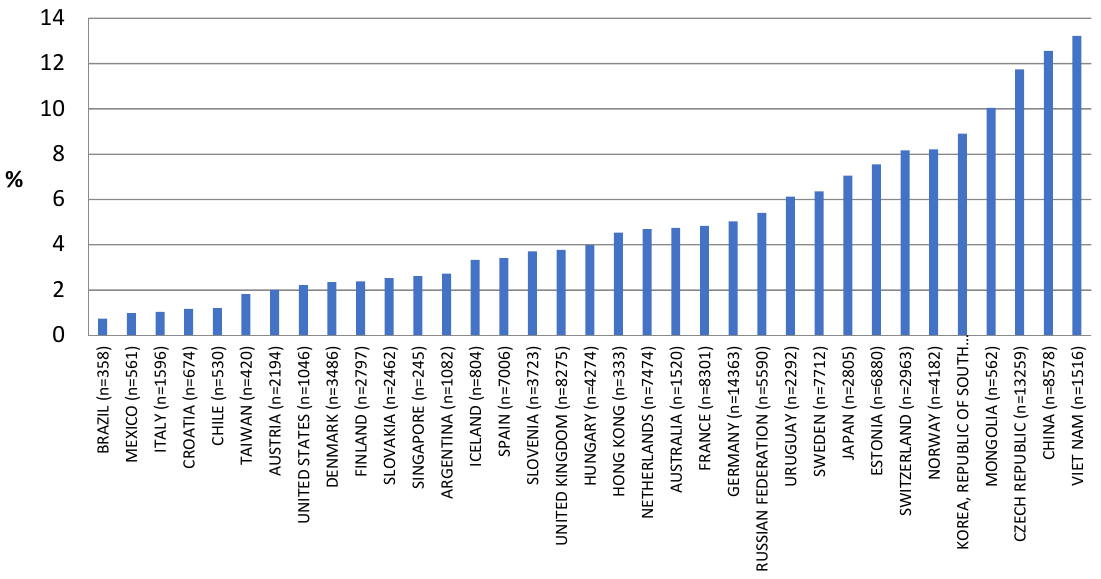
Figure 1. ONBound atheists in percentage of the 35 country samples across all surveys and years.